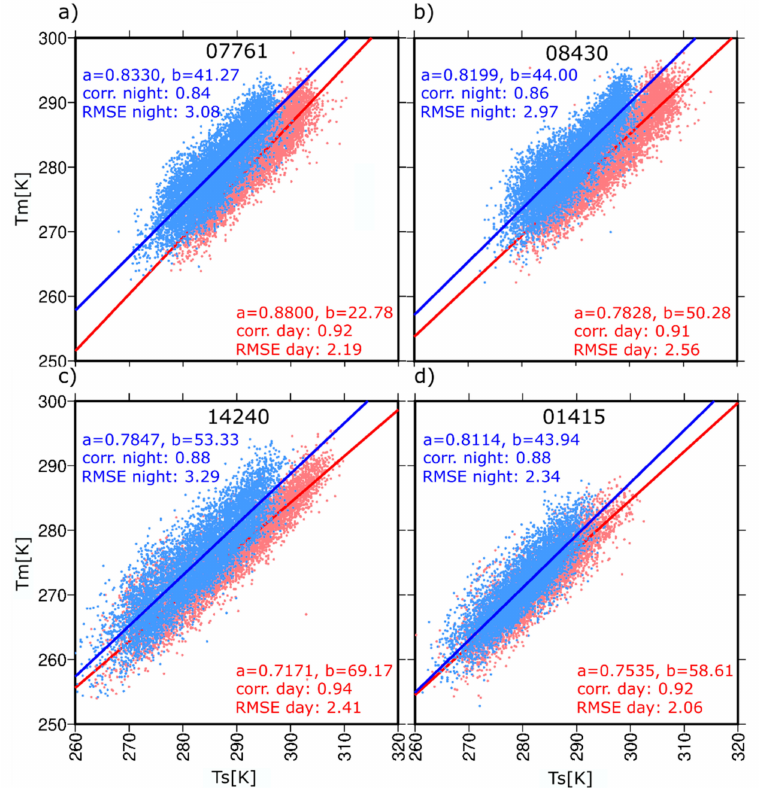
Figure 3. Correlation and T m − T s coe ffi cients for selected RS stations: 07761 (Ajaccio, France) ( a ), 08430 (Murcia, Spain) ( b ), 14240 (Zagreb Maksimir, Croatia) ( c ), and 01415 (Stavanger Sola, Norway) ( d ). The light blue and light pink dots represent observations at 00:00 and 12:00 UTC, respectively. Fitted lines are shown using blue (night) and red (day) lines. Linear regression coe ffi cients ( a and b ), correlation coe ffi cient (corr.) and RMSE for each case are also